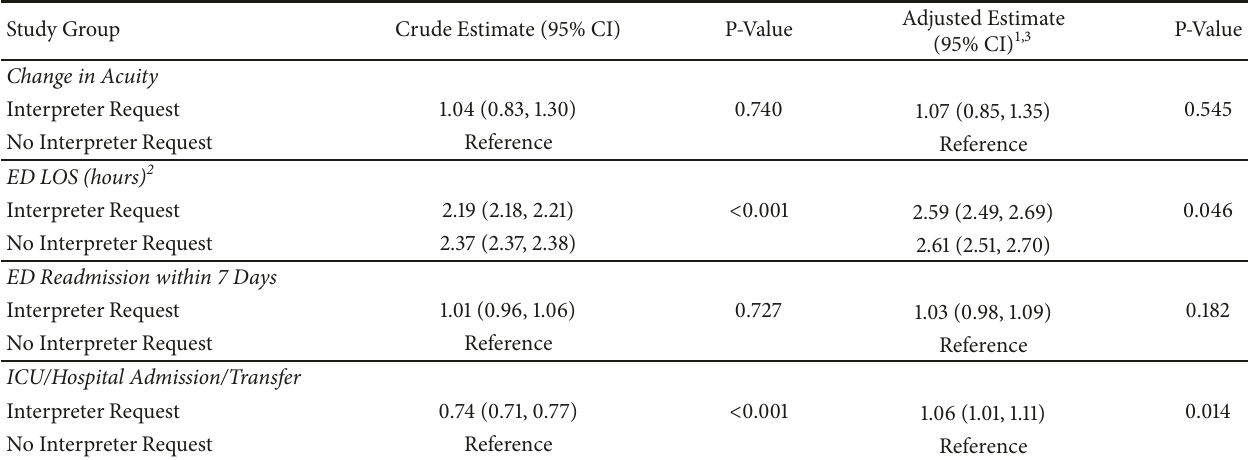
Table 2: Adjusted outcome variables by interpreter needed.